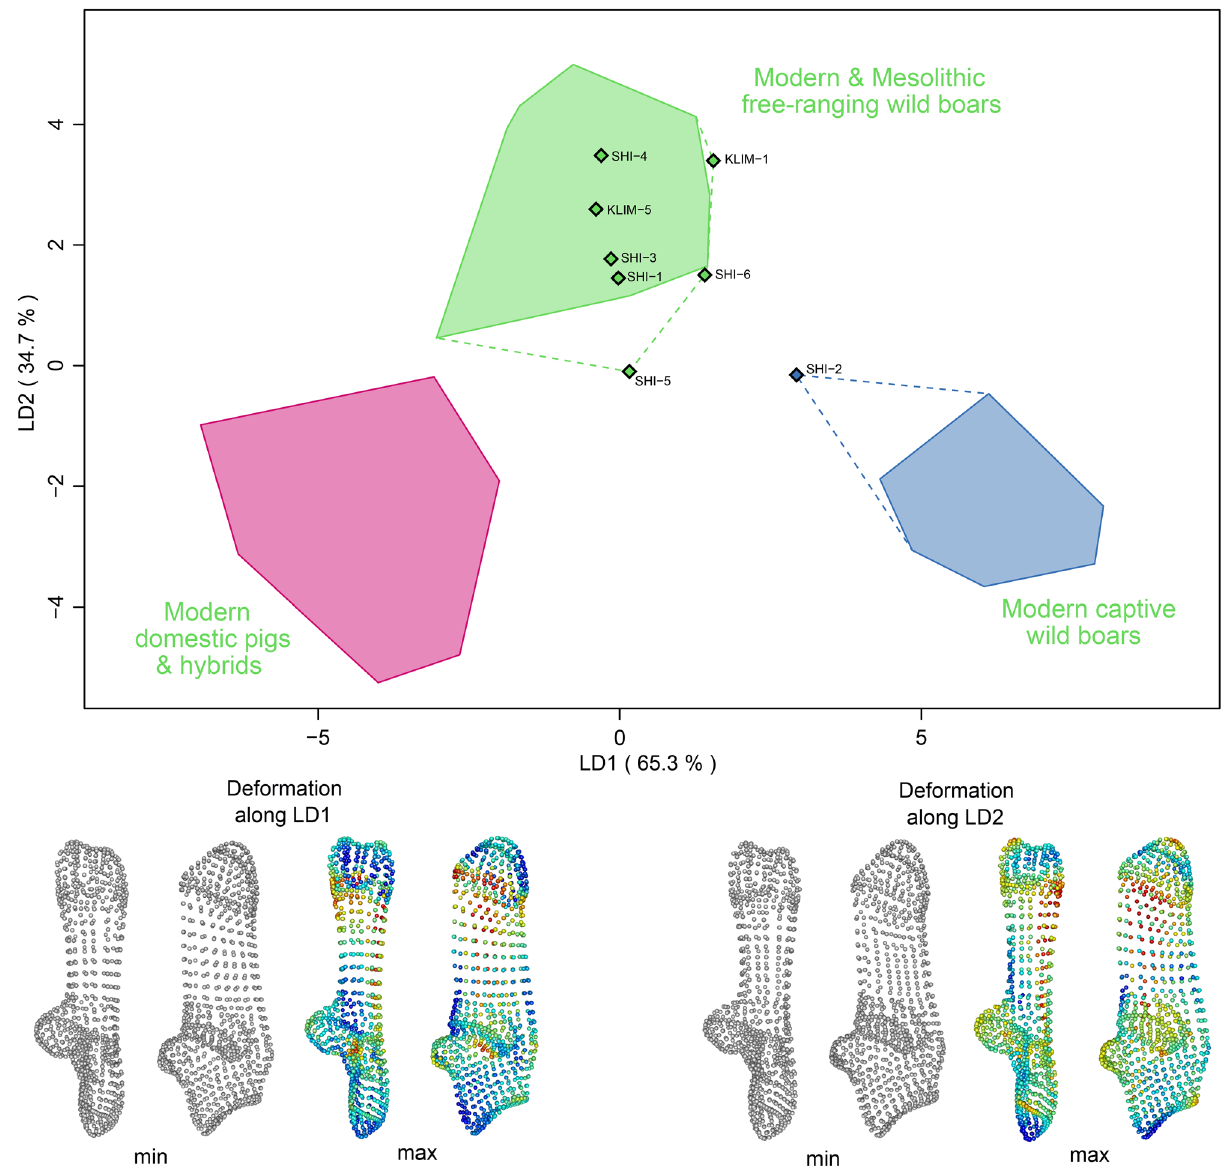
Figure 7. (a) Discriminant shape space of Sus scrofa calcaneus computed from modern and Mesolithic wild boars as well as extant domestic pigs. Modern wild boars include individuals born in the wild but raised in captivity until the age of 2 years. Klimonas (KLIM) and Shillourokombos (SHI) specimens have been projected onto this discriminant shape space and their membership to three morphogroups: free-ranging wild boars, captive wild boars and domestic pigs has been assessed by k-NN algorithm. Deformation along the two discriminant axes are displayed using heatmaps where greater change are shown in